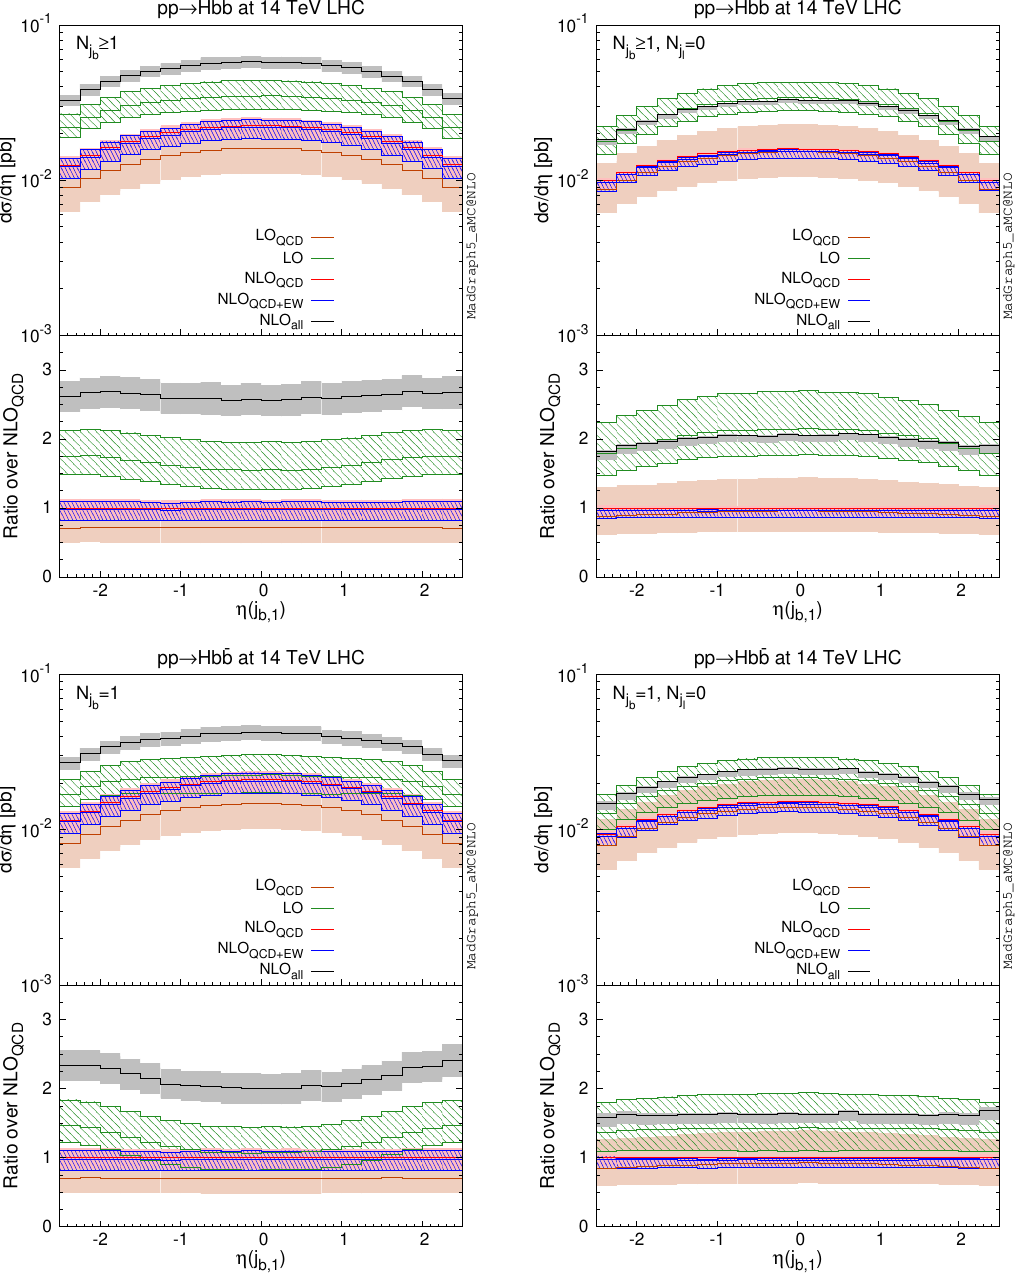
Figure 4 . The η ( j b, 1 ) distribution for N j light-jet veto is